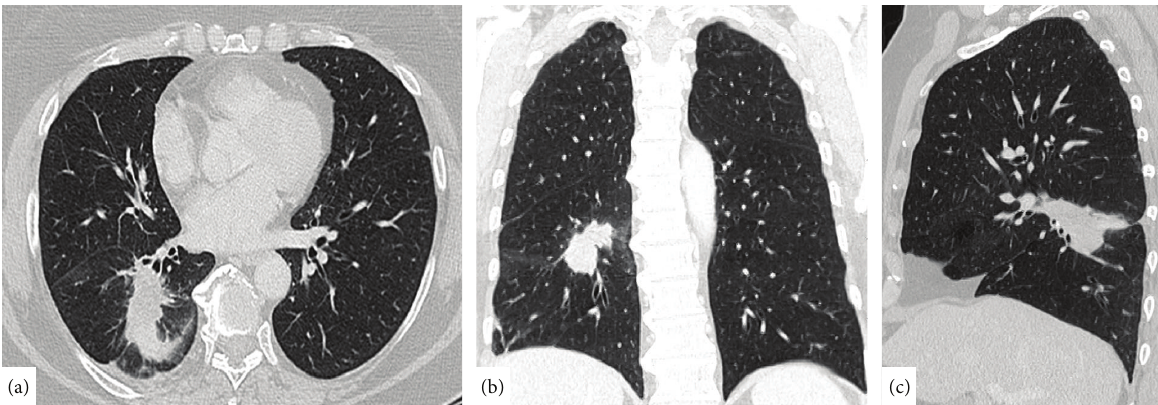
Figure 1: Axial, coronal, and sagittal CT images showing mass lesion in the inferior lobe of right lung.